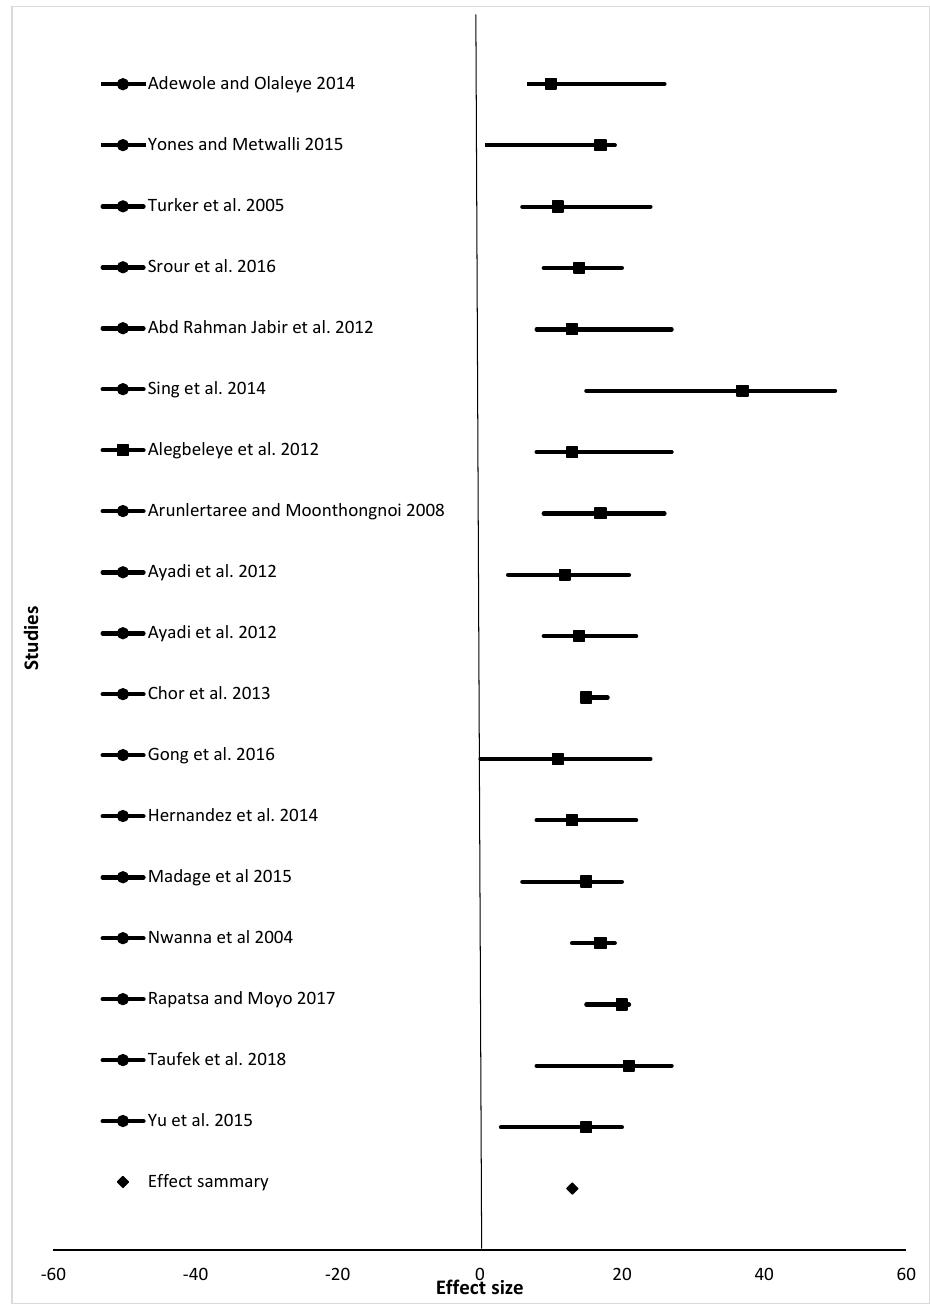
Figure 4. The effect size of feed conversion ratio (%) of fish from different studies fed different animal protein sources compared to fishmeal as a protein source.